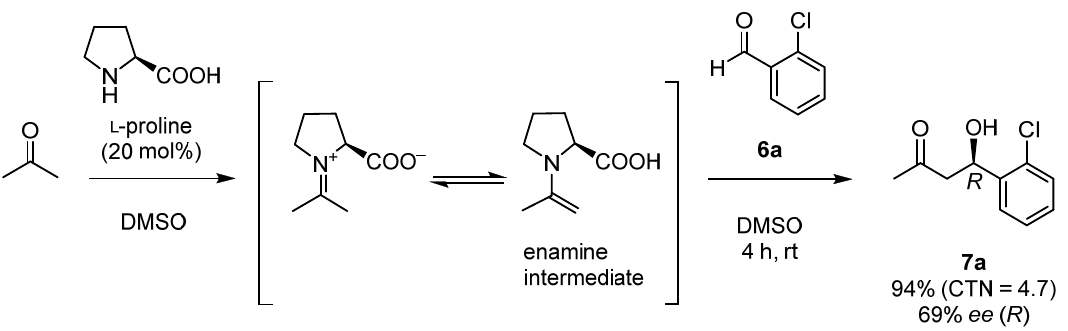
Scheme 3. Direct asymmetric aldol reaction catalyzed by L